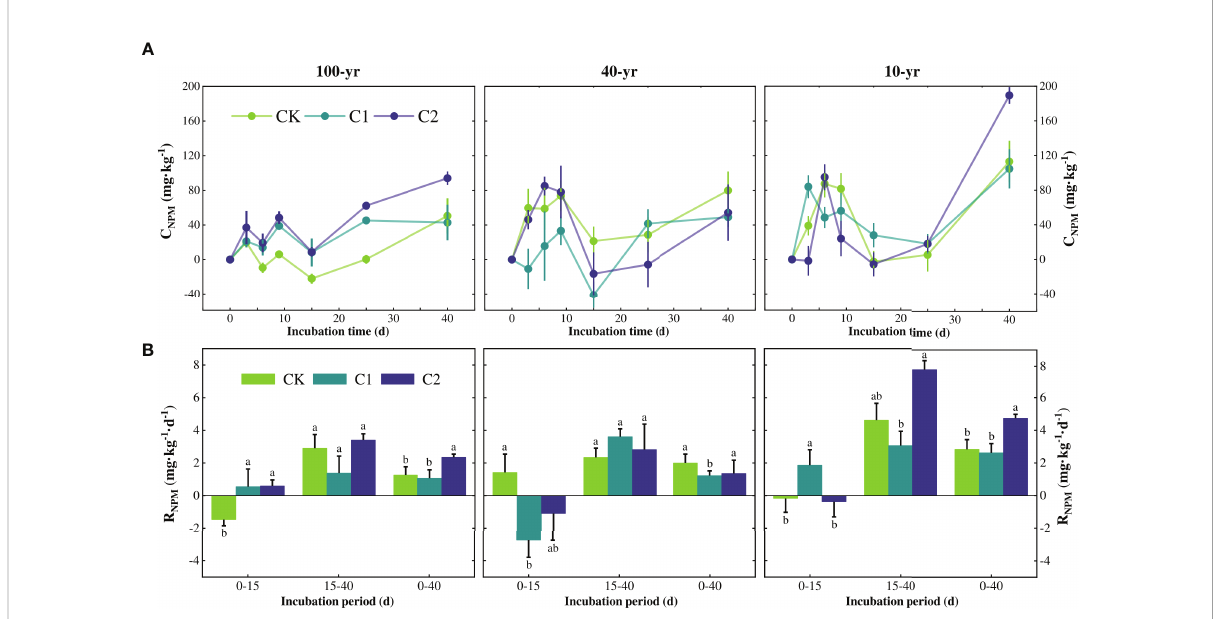
FIGURE 3 C NPM (A) and R NPM (B) in 100-year, 40-year, and 10-year reclaimed soils under the CK, low-dose Cd, and high-dose Cd treatments during 40 days of incubation. Lowercase letters indicate the signi fi cant differences among treatments of different Cd addition ( P < 0.05). Data are means ± standard errors (mean ±